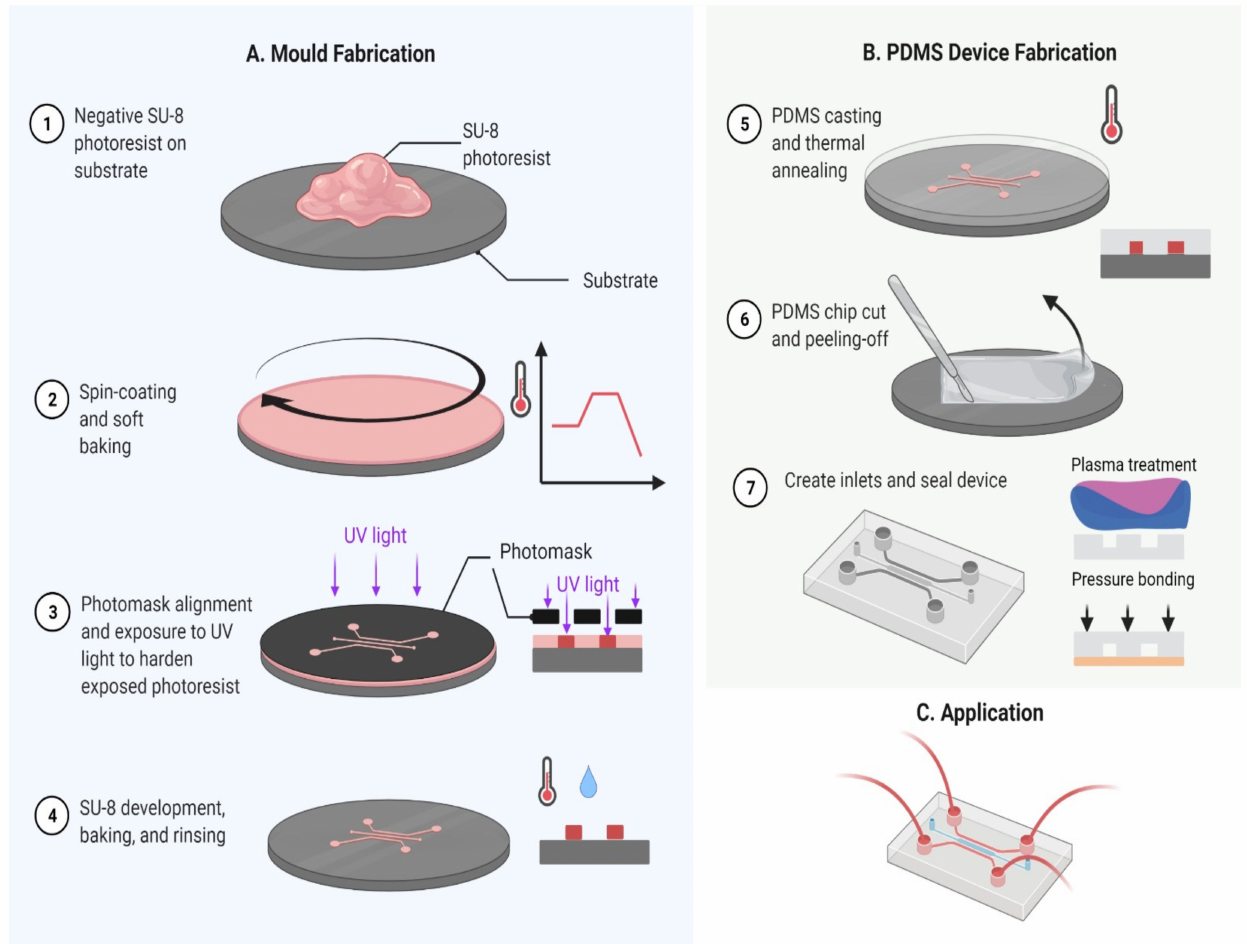
Figure 2. ( A ) Fabrication of an SU-8 master mould; ( B ) casting of polydimethylsiloxane (PDMS) on the mould, plasma treatment, and contact pressure bonding; ( C ) integrating PDMS microfluidic device with world to chip interfaces for